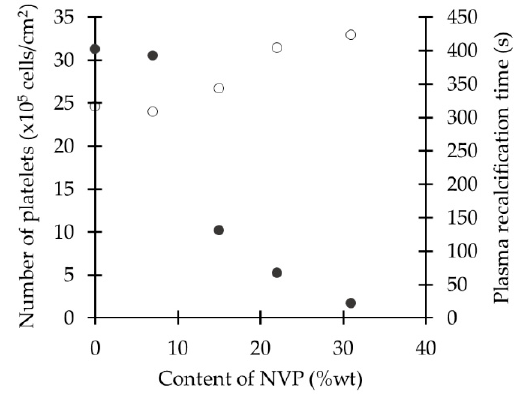
Figure 24. Relationship of N -vinyl-2-pyrrolidone (NVP) content with platelet adhesion (•) and plasma recalcification (PRT) time (o) on PANcNVP. Reprinted from [79] with permission of John Wiley & Sons.